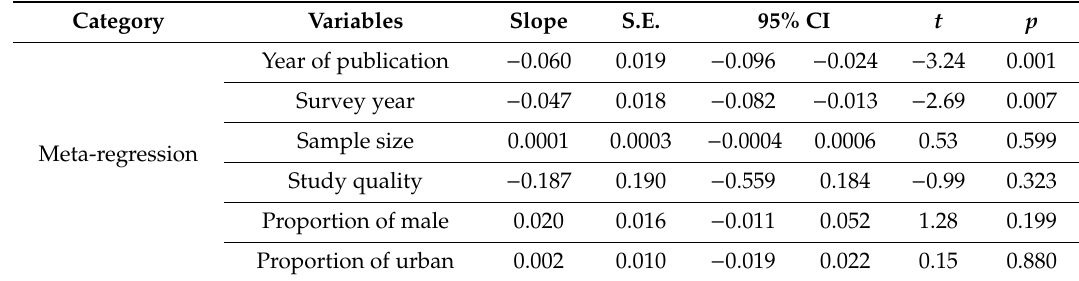
Table 3. Meta-regression analyses.